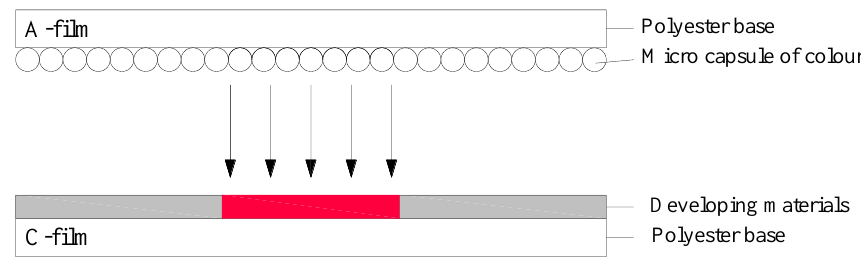
Figure 1. Tire – pavement friction.